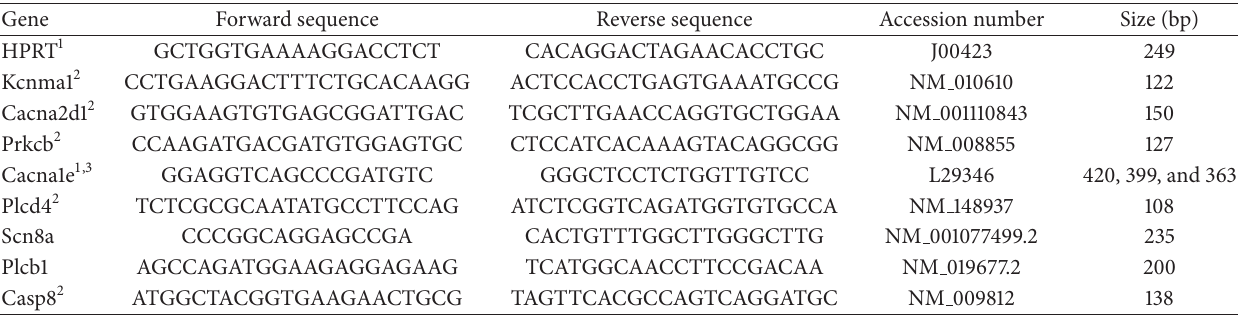
Table 1: Sequence of primer pairs used for